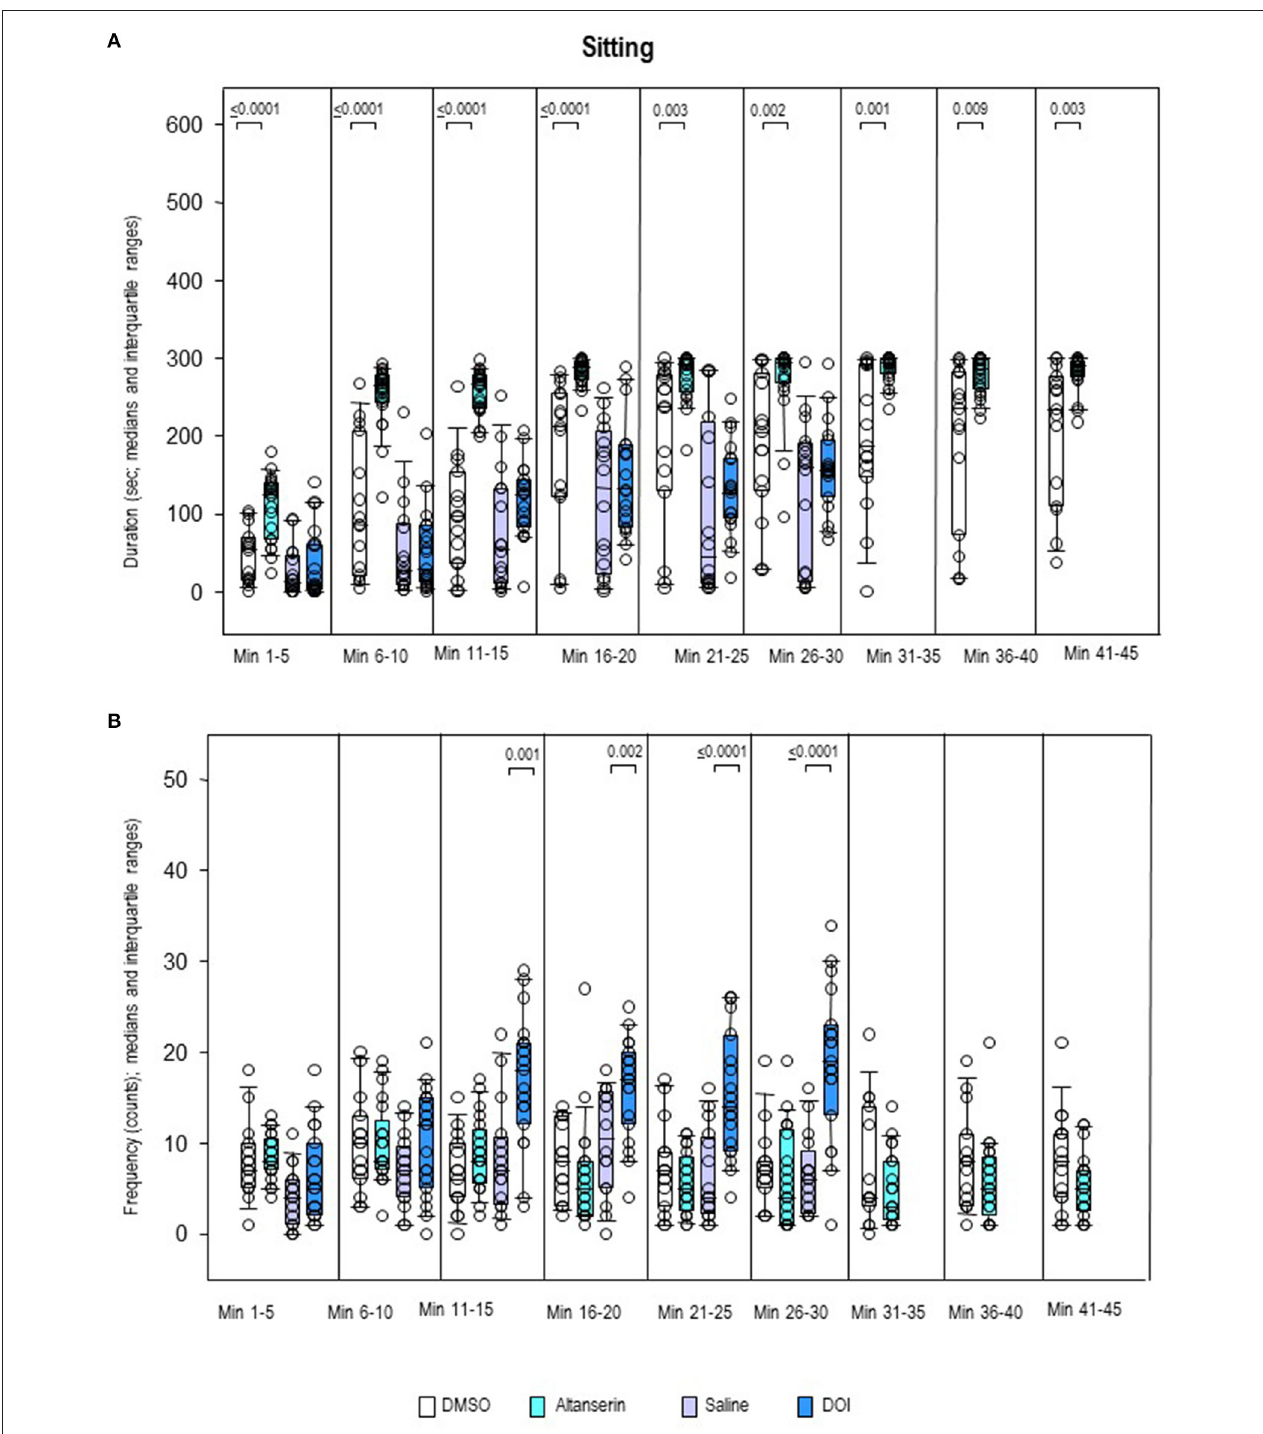
FIGURE 8 | Sitting. Duration (s) and frequency (counts) after 10 mg/kg of altanserin (turquoise), 0.5 mg/kg of 2,5-dimethoxy-4-iodoamphetamine (DOI; blue), and the respective vehicles [dimethyl sulfoxide (DMSO), white; saline, light purple]. The figure shows box and whisker plots of median sitting durations (A) and frequencies (B) in the individual 5-min bins. The 25th/75th percentiles are given in the boxes, while the 5th/95th percentiles are represented by the whiskers. The circles represent the individual animals. Groups (altanserin vs. DMSO; DOI vs. saline) were compared with the independent Mann–Whitney U -test (two-tailed, α = 0.05). Significant p -values are